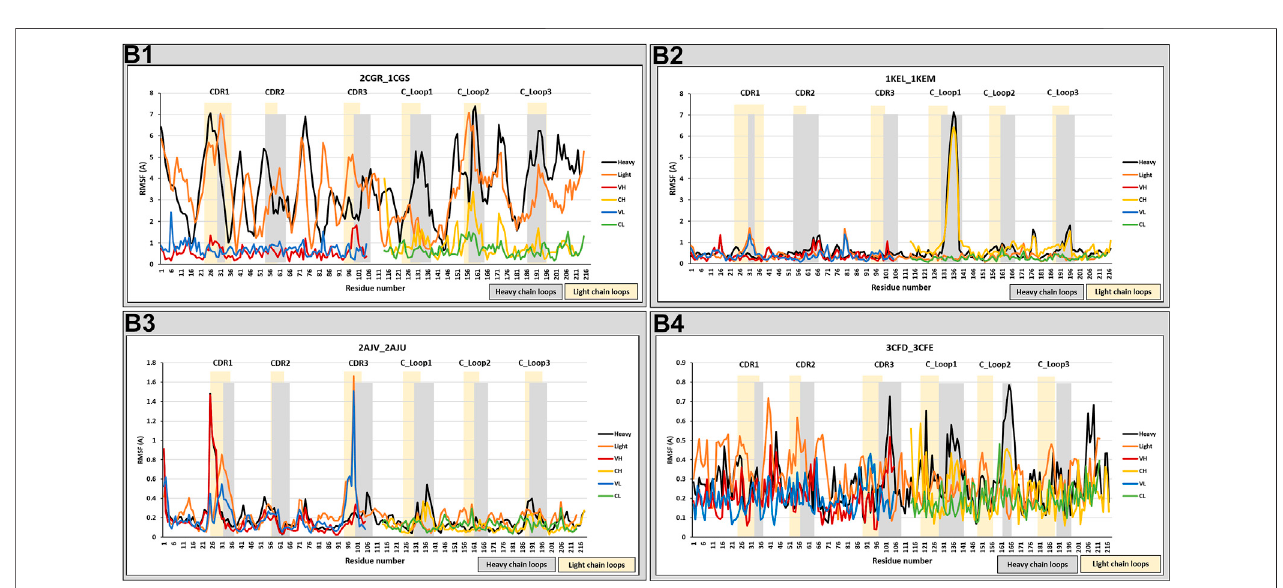
FIGURE 3 | RMSF analysis. RMSF measurements were analyzed for anti-hapten Fabs. Classes B1, B2, B3, and B4 are represented by 2CGR_1CGS, 3CFD_3CFE,2AJV_2AJU,and1KEL_1KEM,respectively.TheRMSF comparisonwasperformedonthetotalchain(heavyandlight)andindependently ontheirspeci fi c domains(V H ,C H1 ,V L ,andC L ).Heavychainloopswerehighlightedingreyandlightchainloopswerehighlightedinyellow.The x -axisdenotestheaminoacidpositionsof either the heavy or light chain, permitting them to be examined in the same fi